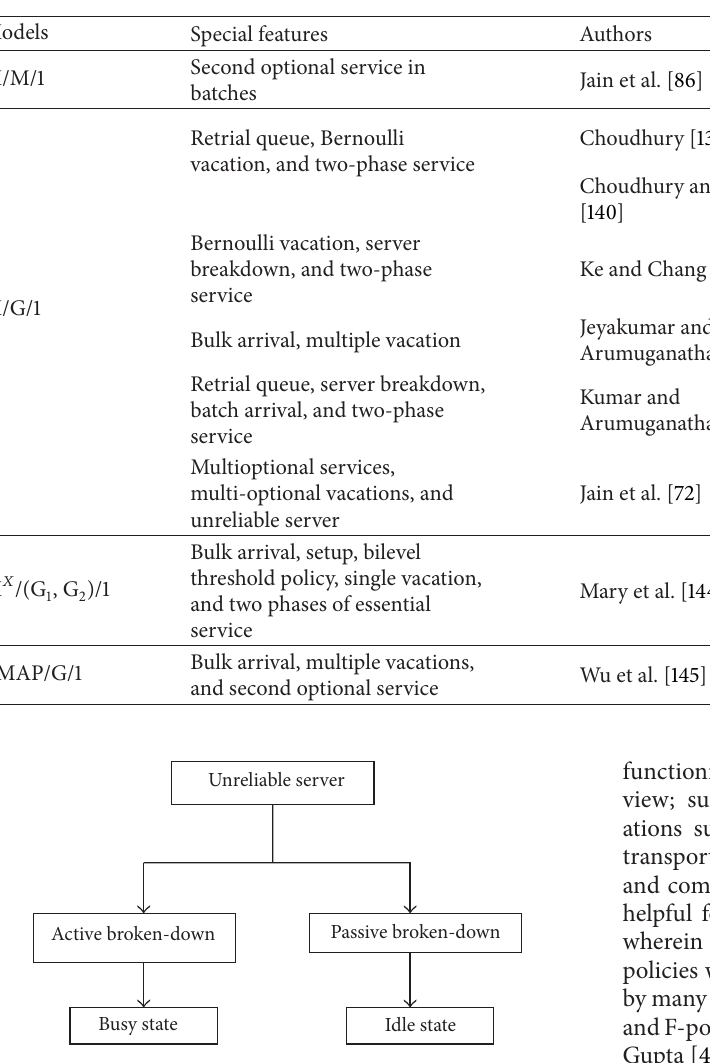
Figure 5: Queueing system with unreliable